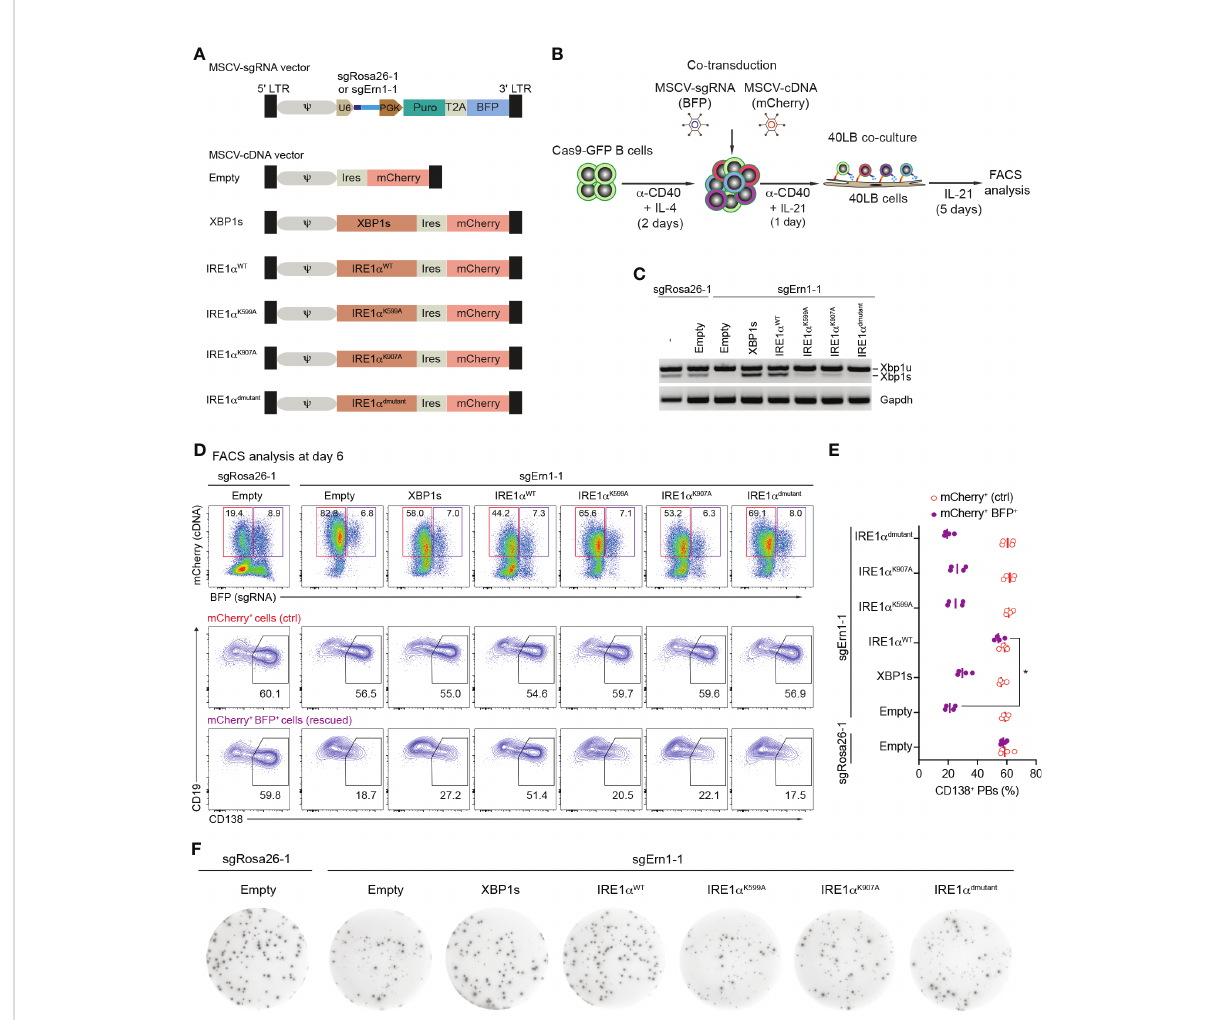
FIGURE 3 Over-expression of Ern1 /IRE1 a , but not Xbp1 cDNA rescues PB formation in Ern1 KO cells. (A) Scheme of MSCV-mCherry vectors expressing cDNAs for XBP1s, IRE1 a WT , IRE1 a K599A , IRE1 a K907A , or IRE1 a dmutant (double mutant), respectively. As a negative control, empty vector was used. (B) Experimental scheme of co-transduction for activated Cas9-expressing B cells transduced with combinations of retroviral particles expressing an sgRNA (BFP + ), targeting either Rosa26 (sgRosa26-1) or Ern1 (sgErn1-1) genes, and a cDNA (mCherry + ). (C) Xbp1u and Xbp1s mRNAs were quanti fi ed 4 days post transduction with the indicated sgRNA/cDNA combinations by semiquantitative-PCR of sorted BFP + mCherry + cells. (D) FACS analysis of the percentage of PB differentiation, indicated by the expression of CD138, at day 6 after co- transduction in mCherry + (ctrl, red) or BFP + mCherry + (rescued, magenta) cell populations. (E) Quanti fi cation of the frequency of CD138 + PBs corresponding to the experiment shown in (D) plus three biological repeat experiments (statistically signi fi cant difference is indicated: Mann- Whitney U-test, *, p=0.02; each dot represents one independent experiment; vertical line indicates median). (F) ELISPOT images showing antibody secretion in the Cas9-expressing B cells transduced with the indicated retroviral combinations. Data are representative of three independent experiments (see also Supplementary Figure